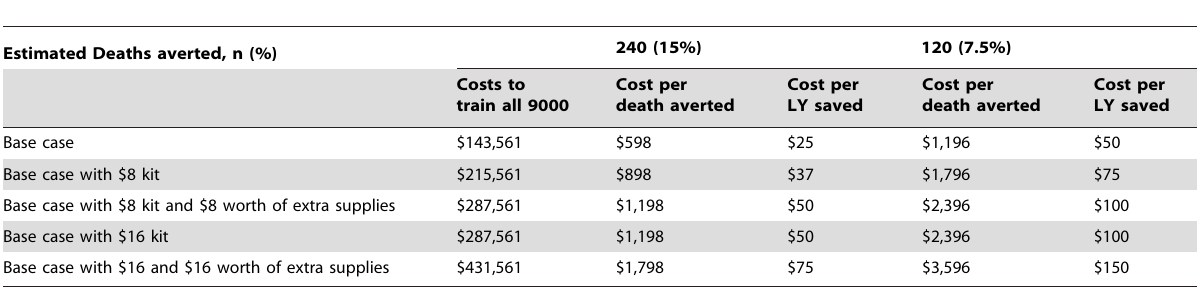
Table 7. Cost per death averted and per life year saved of training 9000 lay first responders.